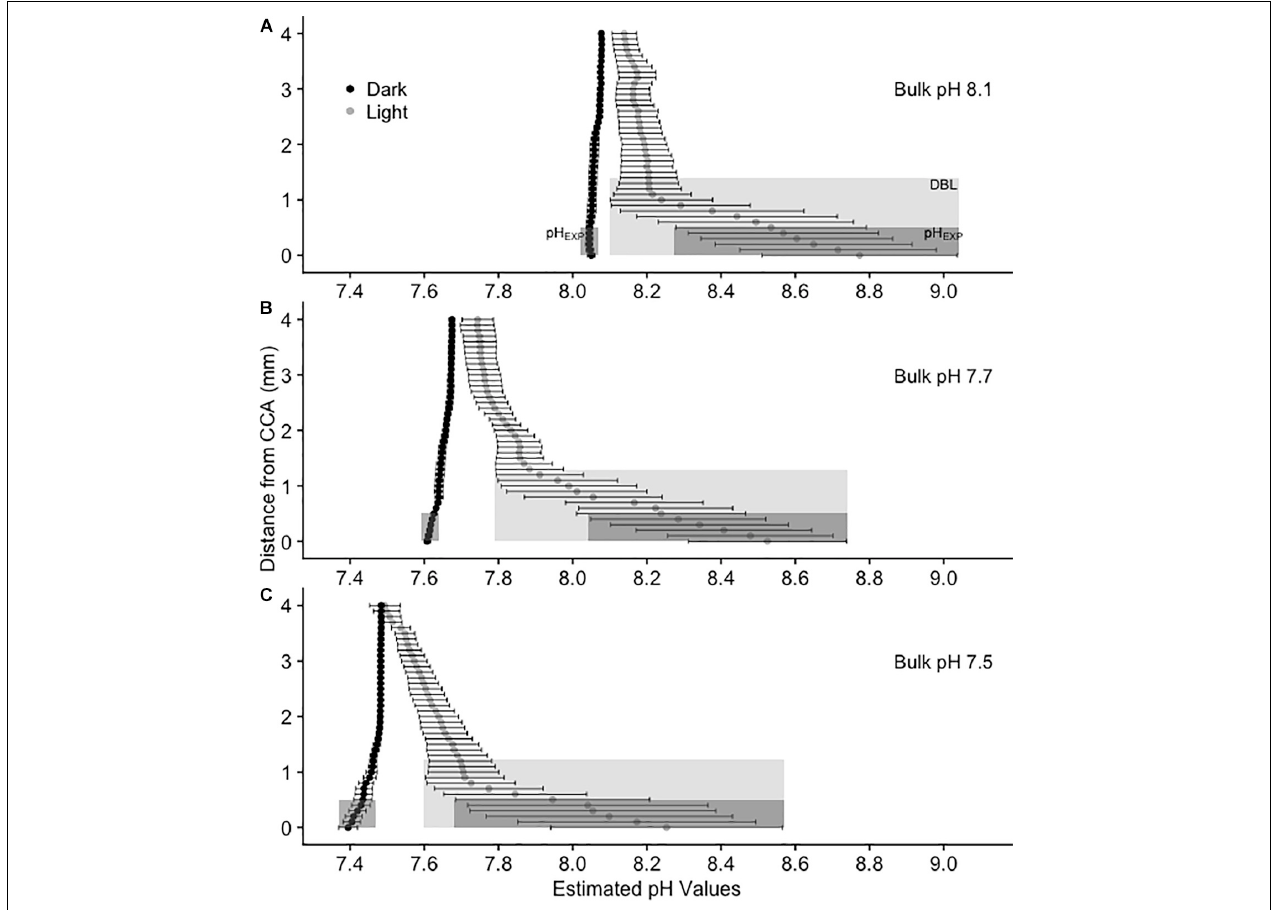
FIGURE 2 | Calculated average pH ( T ) values above CCA in 3 L experimental aquaria at three bulk pH levels: (A) 8.1, (B) 7.7, and (C) 7.5. Values are mean pH ± SE, n = 4. pH values were estimated using oxygen as a proxy. Black circles represent dark treatments and gray circles represent light treatments. The light gray shaded rectangle represents the diffusion boundary layer and the dark gray shaded rectangle represents the pH from 0 to 0.5 mm above the CCA surface (pH EXP ), or the average pH that metamorphosing and newly settled P. huttoni on CCA substrates experience.